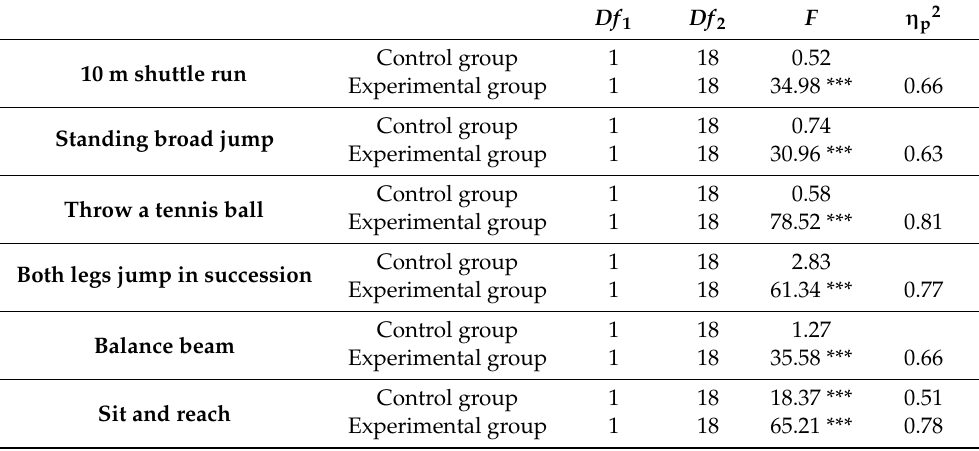
Table 3. Post hoc test results of repeated ANOVA of 2 (group: experimental group and control group) × 2 (test time: pre-test and post-test) for six indexes of the physical